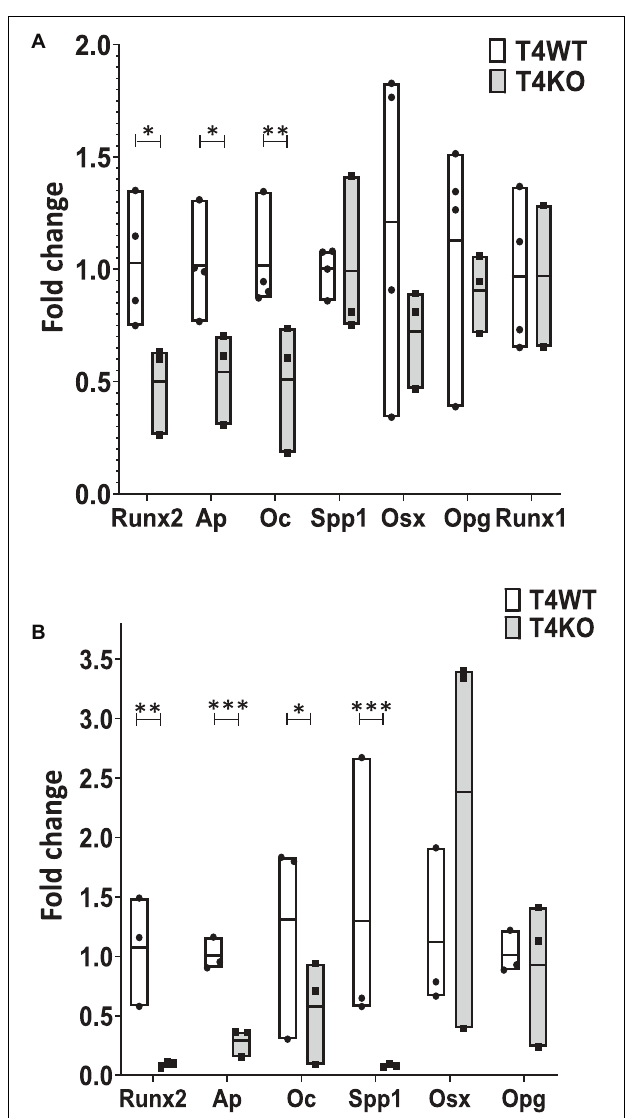
FIGURE 3 | Loss of Tle4 affects expression of osteoblast function and differentiation regulators. (A) qRT-PCR using RNA from 1-week old T4WT and T4KO flushed whole bone lysate shows T4KO has decreased expression of Ap, Runx2, and Oc ( n = 6 biologic replicates, technical triplicates; * p < 0.05, ** p < 0.01, Student t -test). (B) Stromal cultures from T4WT and T4KO were lysed for qRT-PCR analysis, which shows significantly reduced levels of Runx2 , Ap , Oc , and Spp1 expression in T4KO compared to T4WT ( n = 3 biologic replicates per arm, technical triplicates; * p < 0.05, ** p < 0.01, *** p < 0.001, and Student t